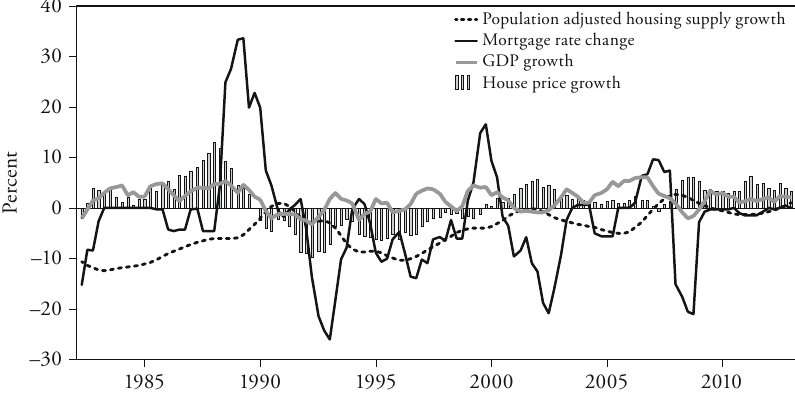
Figure 4: Swiss House Prices, Population Adjusted Housing Supply Growth, Mortgage Rates and GDP Growth over